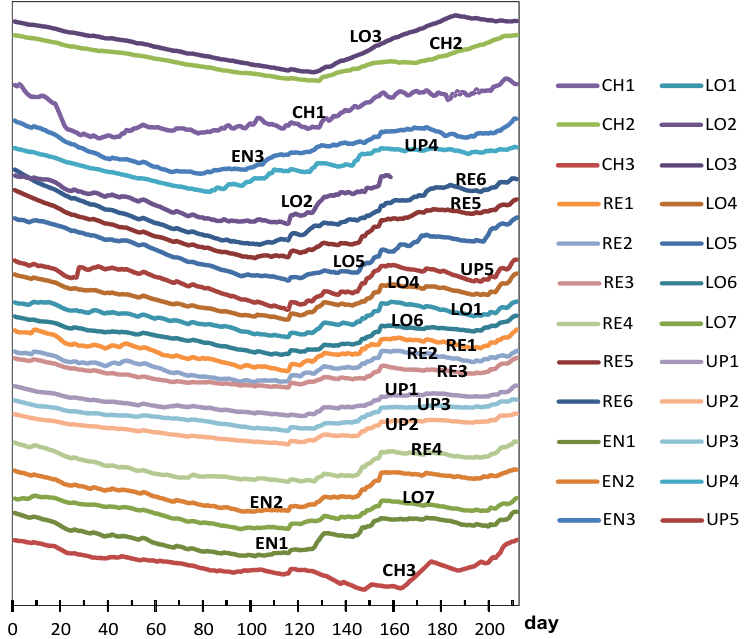
Figure 6. CUSUM charts obtained with the time series of daily ranges of temperature. Charts were conveniently scaled and moved up or down so that those with a similar shape appear close to each other. Nodes OUT and SAC were disregarded. The origin of coordinate, i.e., day 0, corresponds to 0:00 h of 1 August 2017.